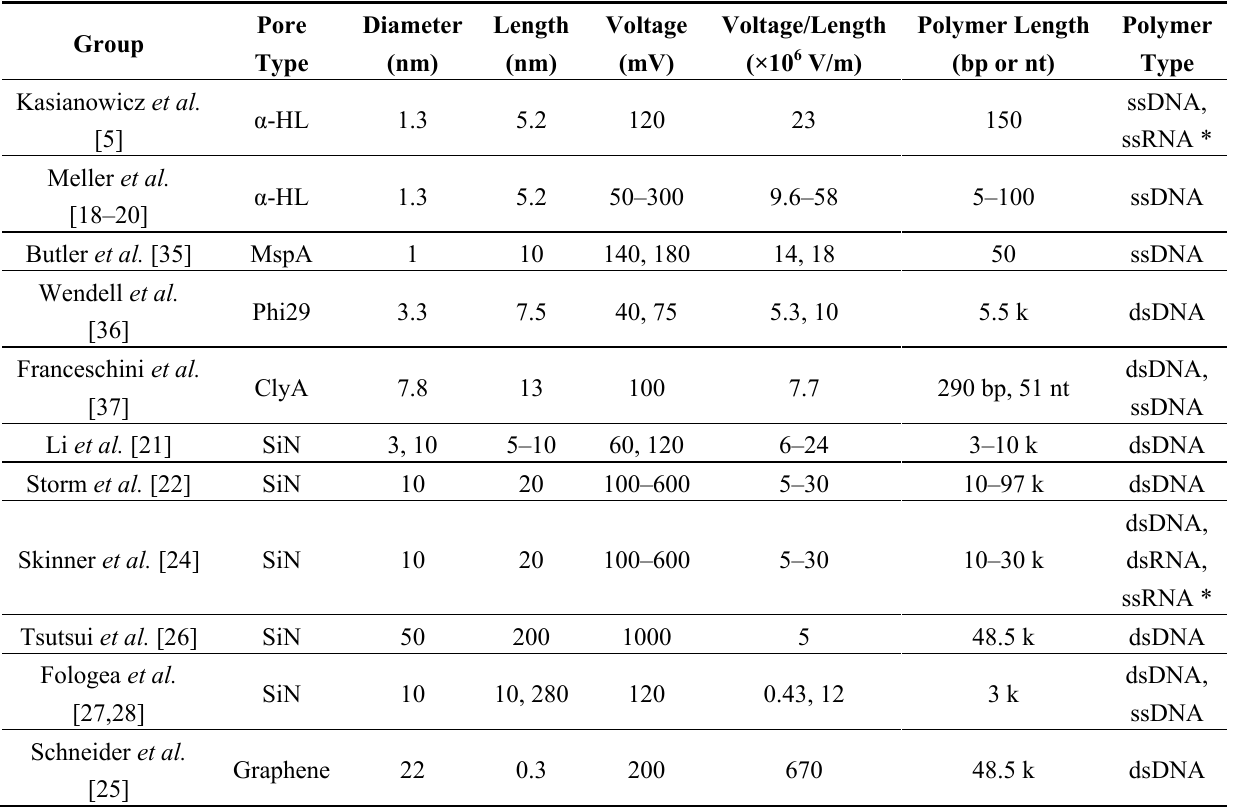
Table 1. Nanopore devices and deoxyribonucleic acid (DNA)/ribonucleic acid (RNA) samples used in published experimental